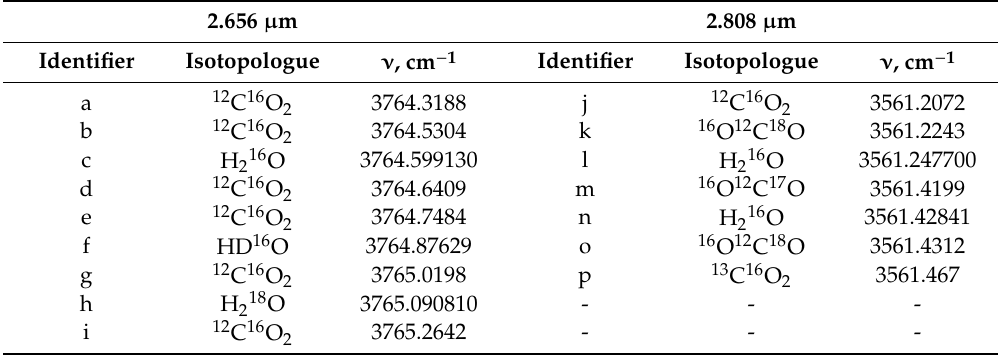
Table 3. Isotopologue abbreviations and central frequency of its transition for both spectral ranges of the M-DLS. Identifiers are according to Figure